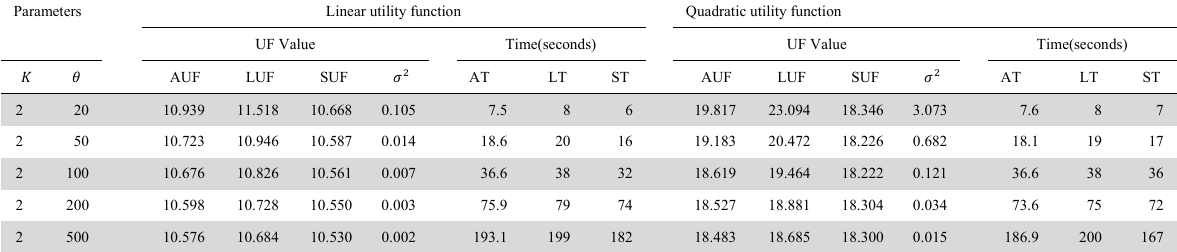
Optimization results of SBKSLS with different amount of random numbers for (cid:1837) (cid:3404) 2 Parameters Linear utility function Quadratic utility